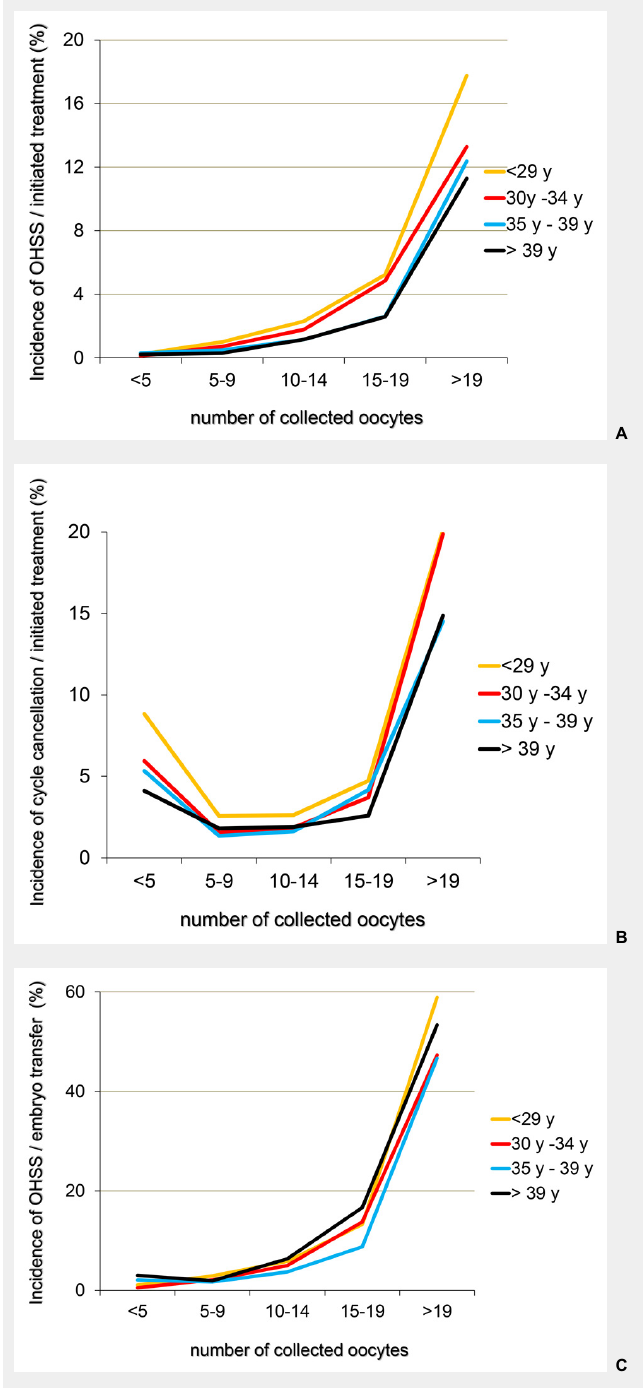
Figures 6 A‒C The incidence of OHSS per initiated controlled ovarian hyperstimulation (in %, panel A), the cancellation rate per initiated cycle and the incidence of OHSS per embryo transfer (in %, panel C) taken from the pooled FIVNAT-CH data collected between 2005 to 2012 were computed in relationship to the number of collected oocytes and the age of the treated infertile patients. The incidence of OHSS rises significantly if more than 14 oocytes are collected. In 17.8% of all treatment cycles in which 19 or more oocytes were collected embryo transfer was cancelled to avoid OHSS. Among all age groups, the cancellation rate was the highest when fewer than five oocytes or 19 or more oocytes were collected (panel